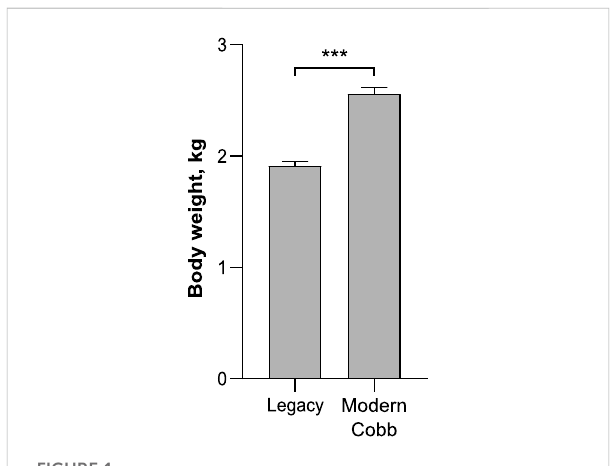
FIGURE 1 Body weight of Legacy line and Cobb line individuals. Data